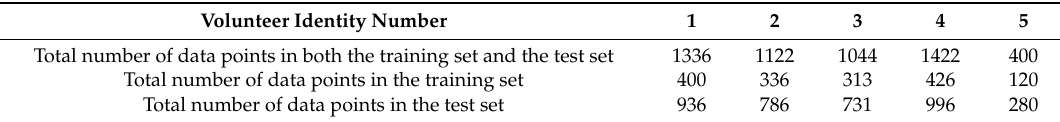
Table 1. The total number of data points in the training and testing